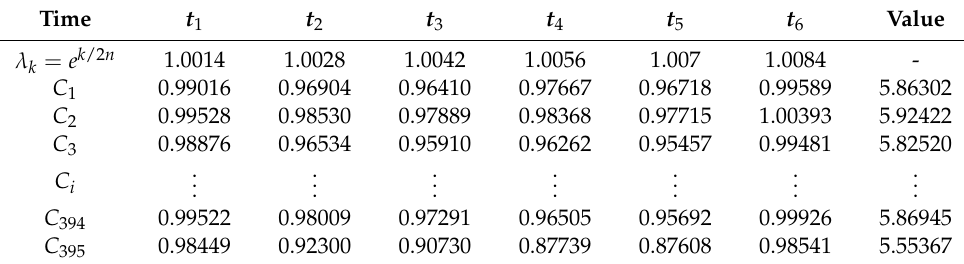
Table 12. The DCE value based on time factors λ k .